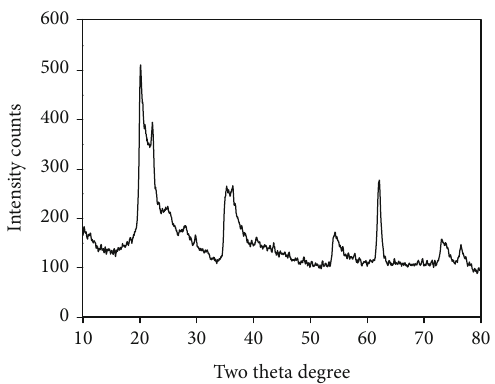
Figure 1: XRD of as received montmorillonite